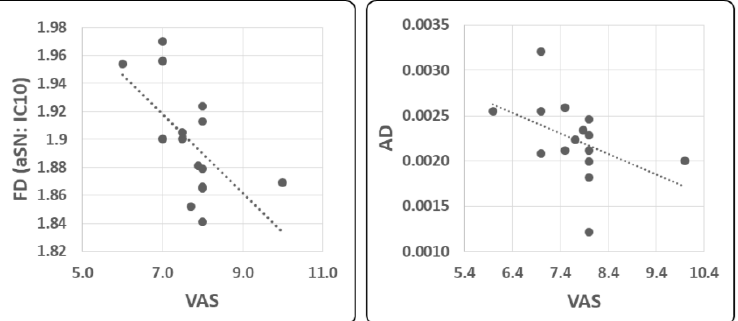
Figure 4. Linear regression analysis between FD values (dimensionless) of IC10 (aSN) BOLD activity and the mean severity of headache (VAS) ( left panel ) and between axial diffusivity (AD) DTI measure and VAS ( right panel ).